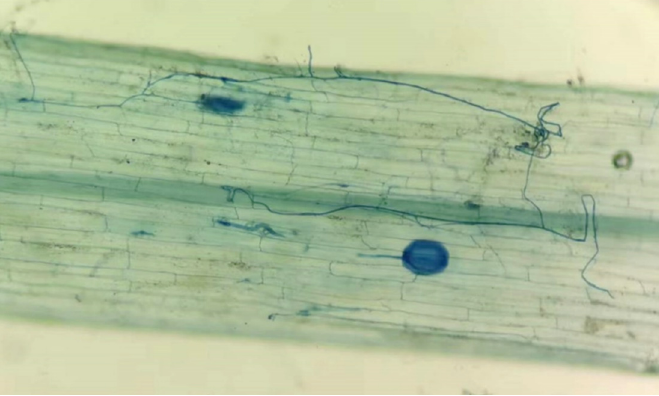
Figure 1. Root colonization of tomato plants by Paraglomus occultum . Table 1. Changes in root colonization and plant growth parameters of tomato plants colonized by Paraglomus occultum under 0 and 150 mM NaCl